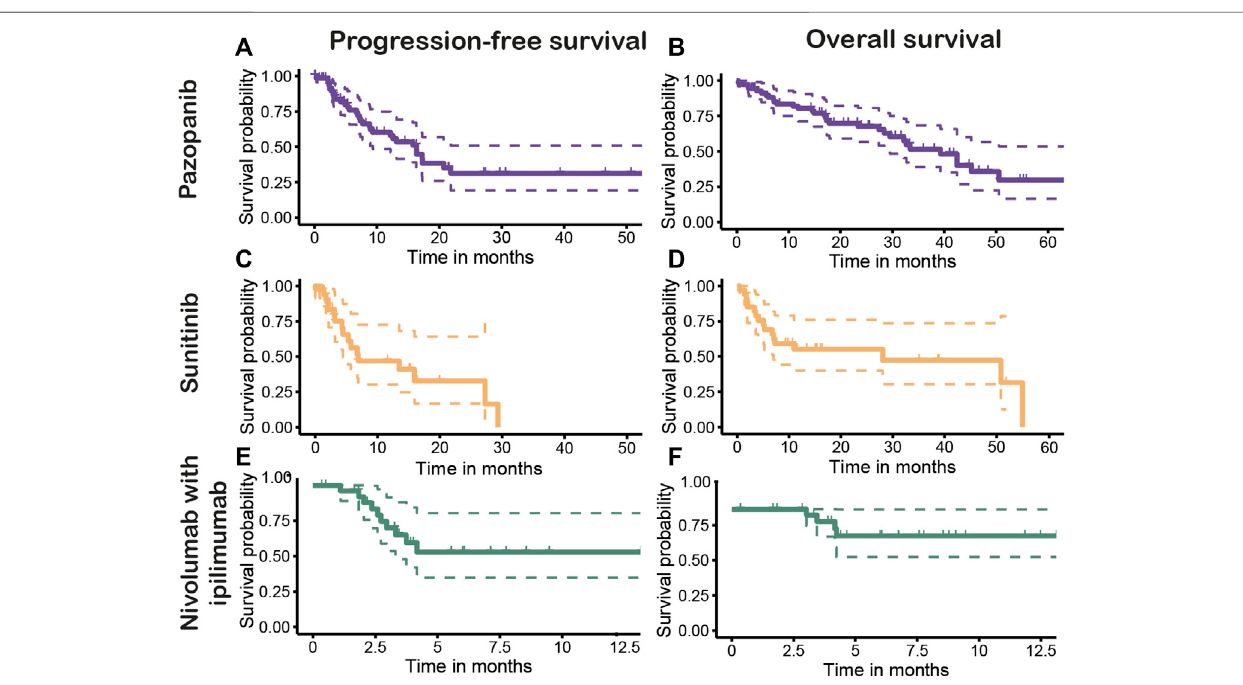
Frontiers in Pharmacology |